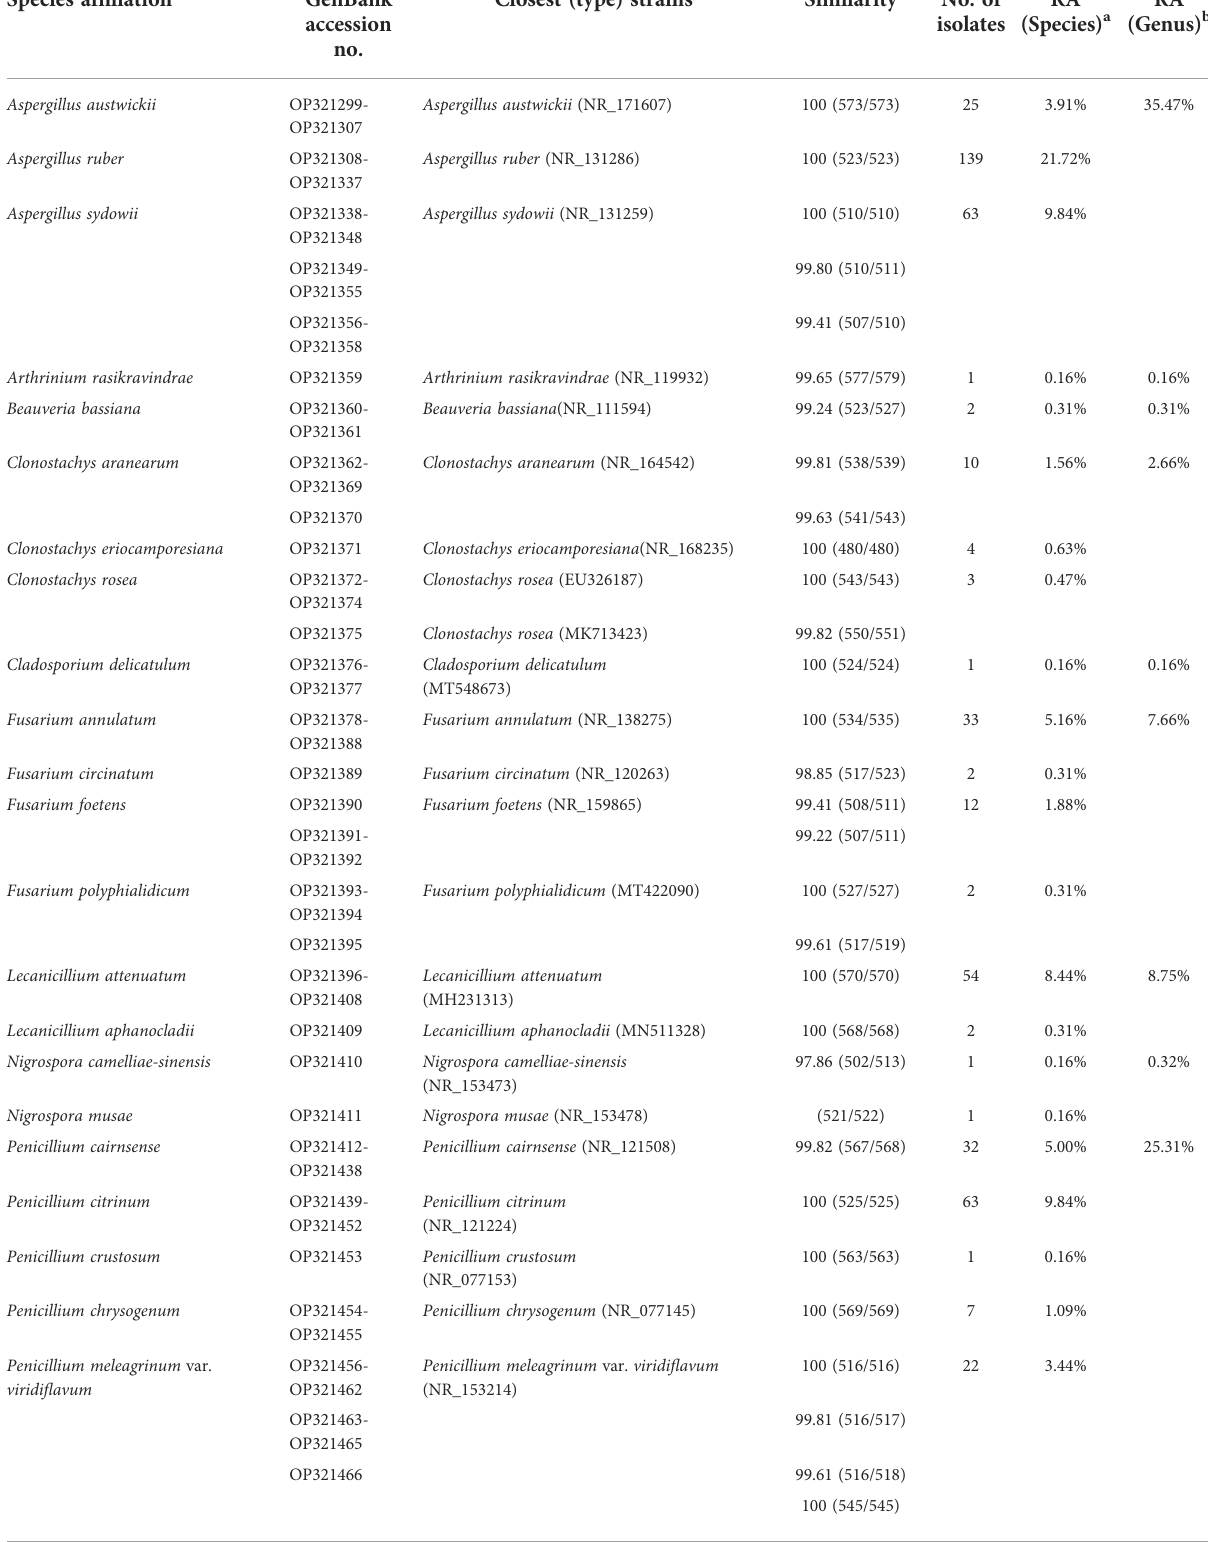
TABLE 1 GenBank accession numbers of fungal isolates from M . alternatus in this study and similarity scores to closest (type) strains in NCBI according to the rDNA-ITS